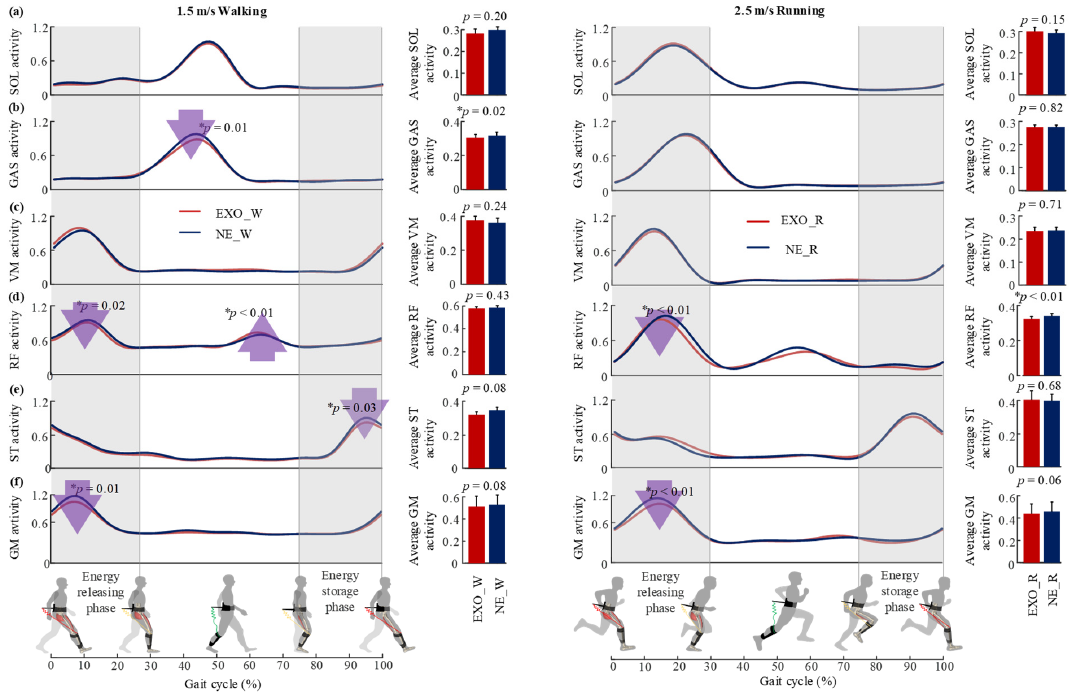
Figure 6. Changes in muscle activities in the tested walking and running conditions. ( a – f ) The activities of soleus (mono-articular muscle and ankle plantarflexor), gastrocnemius (GAS, biarticular muscle, ankle plantarflexor and knee flexor), vastus medialis (VM, major knee extensor), rectus femoris (RF, major hip flexor and knee extensor), semitendinosus (ST, major hip extensor and knee flexor) and gluteus maximus (GM, major hip extensor). The bar graphs represent the average muscle activities over the whole gait cycle in each experimental condition. The asterisk (*) indicates the statistical difference in peak muscle activities and average muscle activities between the tested conditions during walking and running using two-sided paired t